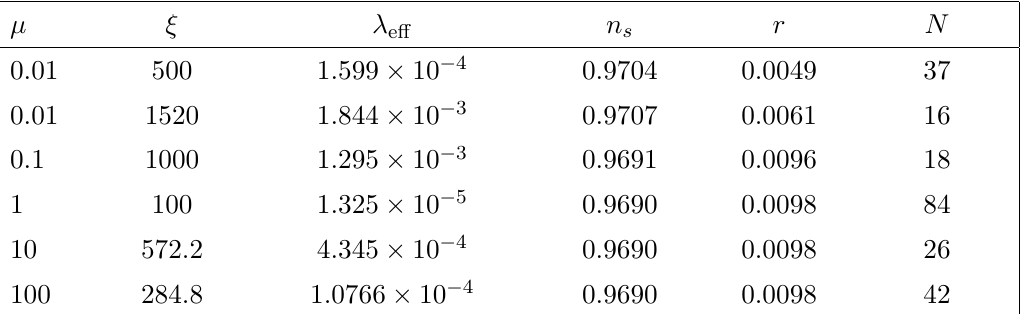
Table 1 . The in(cid:13)ationary observables including the scalar spectral index n ratio r in the non- M -(cid:13)ation model for some typical values of the parameters (cid:22) and (cid:24) . Also, the derived values of the parameter (cid:21) e(cid:11) and number of the D3-branes N are presented in the table. The quantities in this table are evaluated with the horizon exit e-fold number N e =